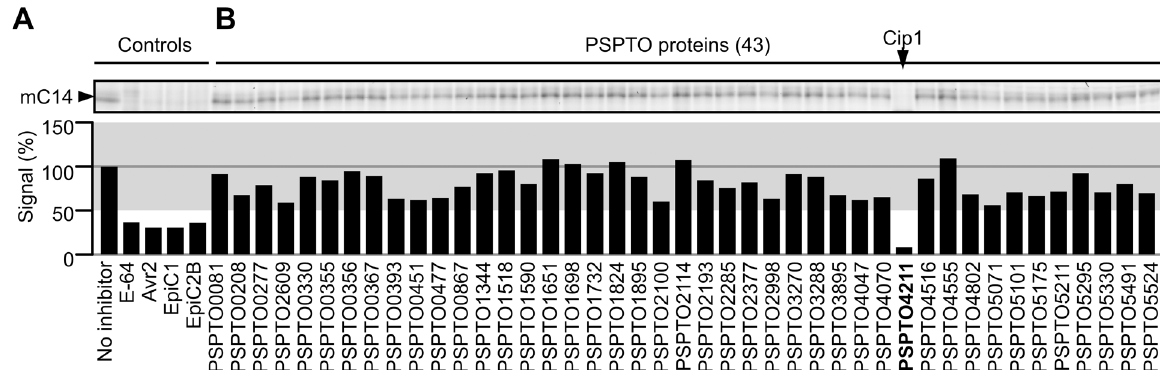
Fig 5. Competitive ABPP screen reveals inhibitor of immune protease C14. Protein extracts of leaves transiently overexpressing the C14 immune protease were pre-incubated with or without 50 μ M E-64 or with 1 μ g purified Avr2, EpiC1 or Epic2B (A) or 1 μ g purified putative effector protein (B) or for 30 minutes and then incubated for one hour with 1 μ M MV201 to label the non-inhibited proteases. Proteins were separated on a 12% protein gel and scanned for fluorescently labeled proteins. The signals were quantified and plotted in a bar graph. The region corresponding to 0.5 to 1.5 times the no-inhibitor-control is shaded grey. This screen was repeated twice with a similar